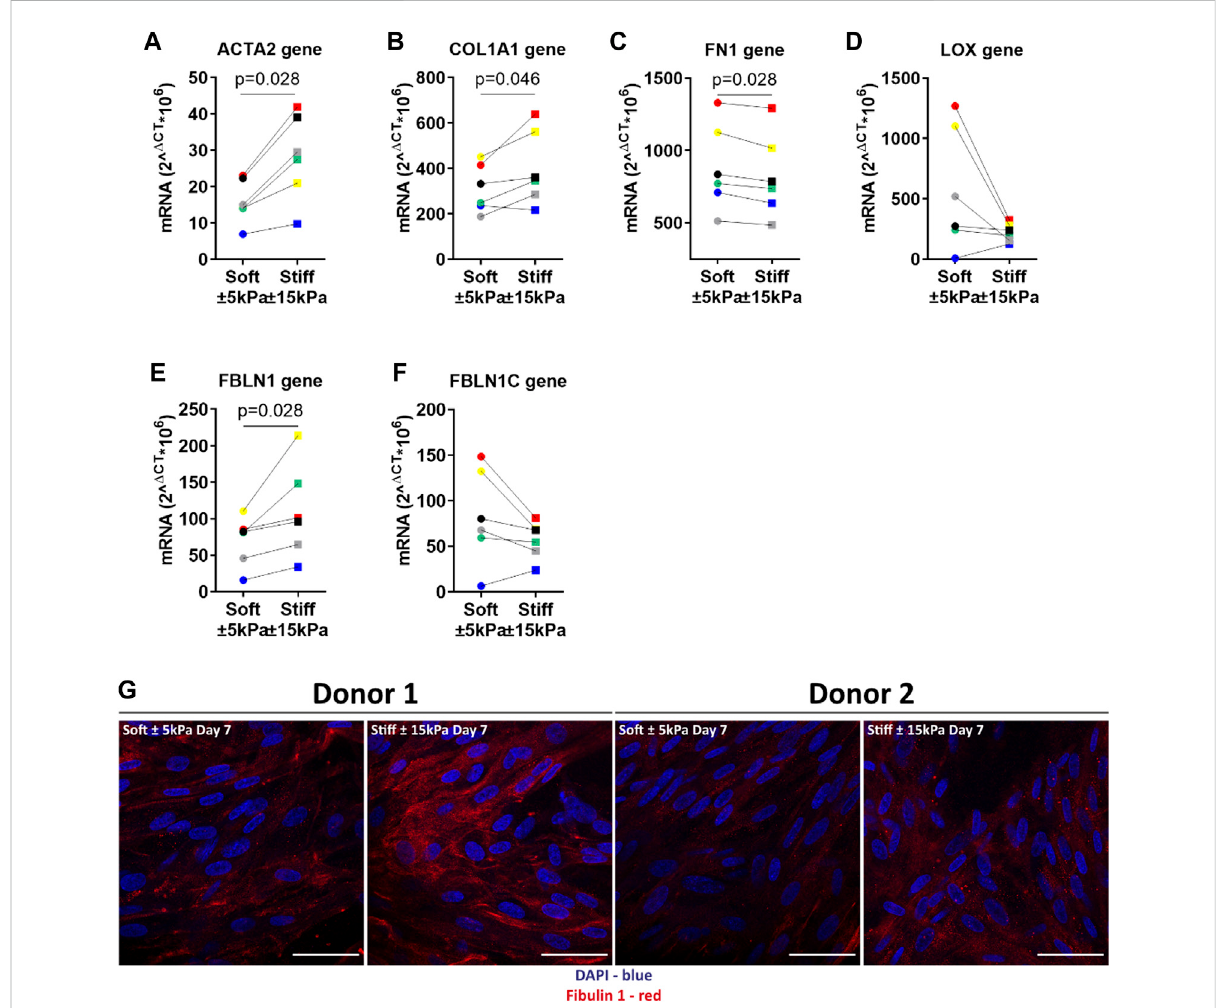
FIGURE 4 Primary human lung fi broblast markers of cellular senescence in response to surface stiffness. (A – C) Gene expression of the cell-cycle inhibitors p21 Waf1/CIp1 and p16 Ink4a , p53 and known SASP factors IL-6 and CXCL8 after 7 days of culture, data were normalised against 18S and expressedas2 − Δ CT x10 6 . (D-G) LevelsofSASPcytokineproductioninsupernatant,datawerenormalisedtocellnumbersandareexpressedaspg/mL per10 5 cells.Differencesbetweensoft(3.94±0.87 kPa)andstiff(11.34±3.82 kPa)hydrogelswereanalysedbyaWilcoxonmatchedpairssigned rank test (n = 6) and p < 0.05 was considered signi fi cant. Each donor has a different unique colour (blue, red, yellow, green, black, and